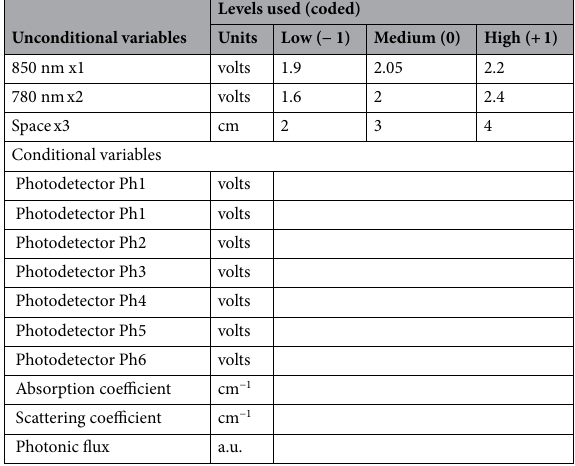
Table 1. Box–Behnken experimental design variables.